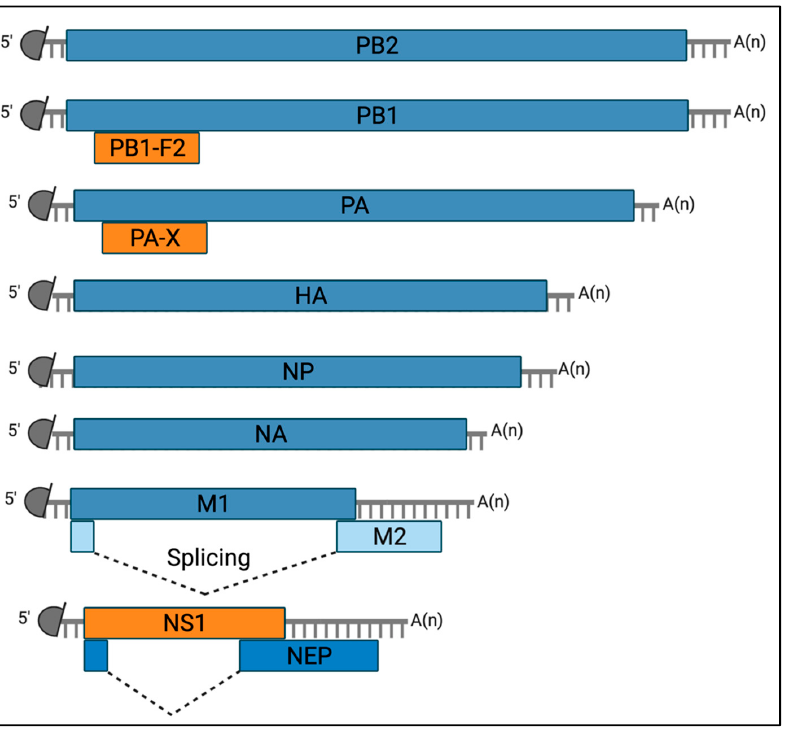
Figure 2. Diagram of the viral mRNAs transcribed from the EIV genome. Schematic representation of the twelve known mRNA molecules transcribed from the EIV genome. Grey semi-circles repre- sent the 5 ′ methylated cap structure and grey lines denote host-derived primers of the 10 to 14 nu- cleotides that are obtained by the cap-snatching mechanism of the viral polymerase. A(n) corre- sponds to the 3 ′ poly-A tail produced by reiterative stuttering of the viral polymerase. Boxes indicate the viral gene product encoded by each mRNA. The constituent of the viral ribonucleocomplex (vRNP), including the three subunits of the viral polymerase (PB2, PB1, and PA) are encoded on segment 1 to 3, respectively, and the Nucleoprotein (NP) on segment 5. The membrane-associated glycoprotein of surface Hemagglutinin (HA) and Neuraminidase (NA) are encoded on segments 4 and 6, respectively. The matrix protein M1 and the ion channel matrix protein M2 are encoded on segment 7, on a colinear mRNA for the former and via alternative splicing (dashed lines) for the latter. The non-structural protein 1 (NS1) is encoded on a colinear mRNA derived from segment 8. This segment also encodes for the Nuclear Export Protein (NEP) mRNA via alternative splicing (dashed lines). Finally, two accessory proteins, PB1-F2 and PA-X, are encoded via partially overlap- ping open reading frames of segments 2 and 3, respectively. Created with https://biorender.com/ (Accessed date 14 November 2021). 2.1.1. NS1 NS1 is encoded on a colinear mRNA of segment 8 [39] (Figure 2) and is most often a 230 amino acid-long protein [43]. However, mutations that either suppress the stop codon at position 231 or create a premature stop codon result in length variations [50]. NS1 rep- resents a major virulence factor common to all IAVs, whose best described function is to antagonize the type I IFN pathway [51–53]. Polymorphisms among NS1 proteins exist [52,54–56], and the protein C-terminus accounts for important functional differences be- tween viral strains and subtypes. Indeed, some NS1 proteins harbor an “ESEV/EPEV” PDZ binding motif from residues 227 to 230. This motif is usually found in IAVs that infect birds [57]. PDZ domains are protein-protein recognition modules within a multitude of proteins that organize diverse cell-signaling assemblies [58], and notably cellular apopto- sis. NS1 proteins carrying the “ESEV/EPEV” motif have notably been shown to inhibit cellular apoptosis through interaction with Scribble [59,60]. In the case of EIV, virus iso- lates in circulation from viral emergence in 1963 until the late 1990s expressed a 230 amino